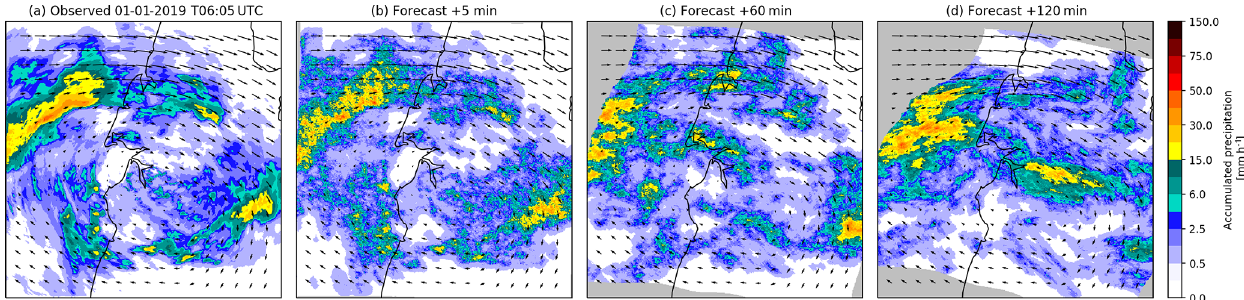
Figure 20. Comparison of a member of 5min rainfall ensemble for (b) + 30min, (c) + 60min and (d) + 120min nowcasts initialized with (a) radar-based rainfall analysis from the Australian radar network valid at 06:05UTC on 1 January 2019 on a 512 × 512 pixel grid (256 × 256km) (event no. 2 in Table 10).